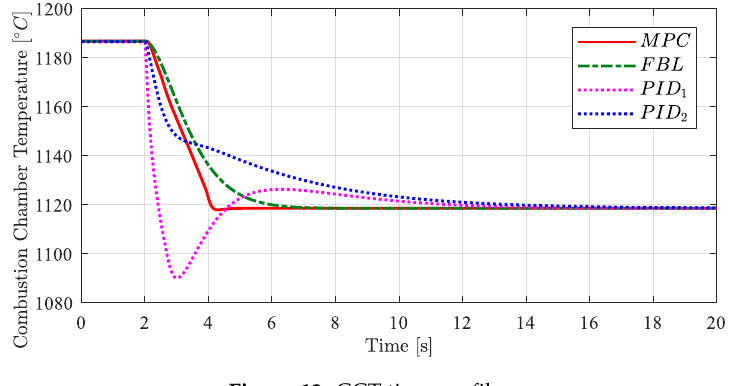
Figure 13. CCT time profile.